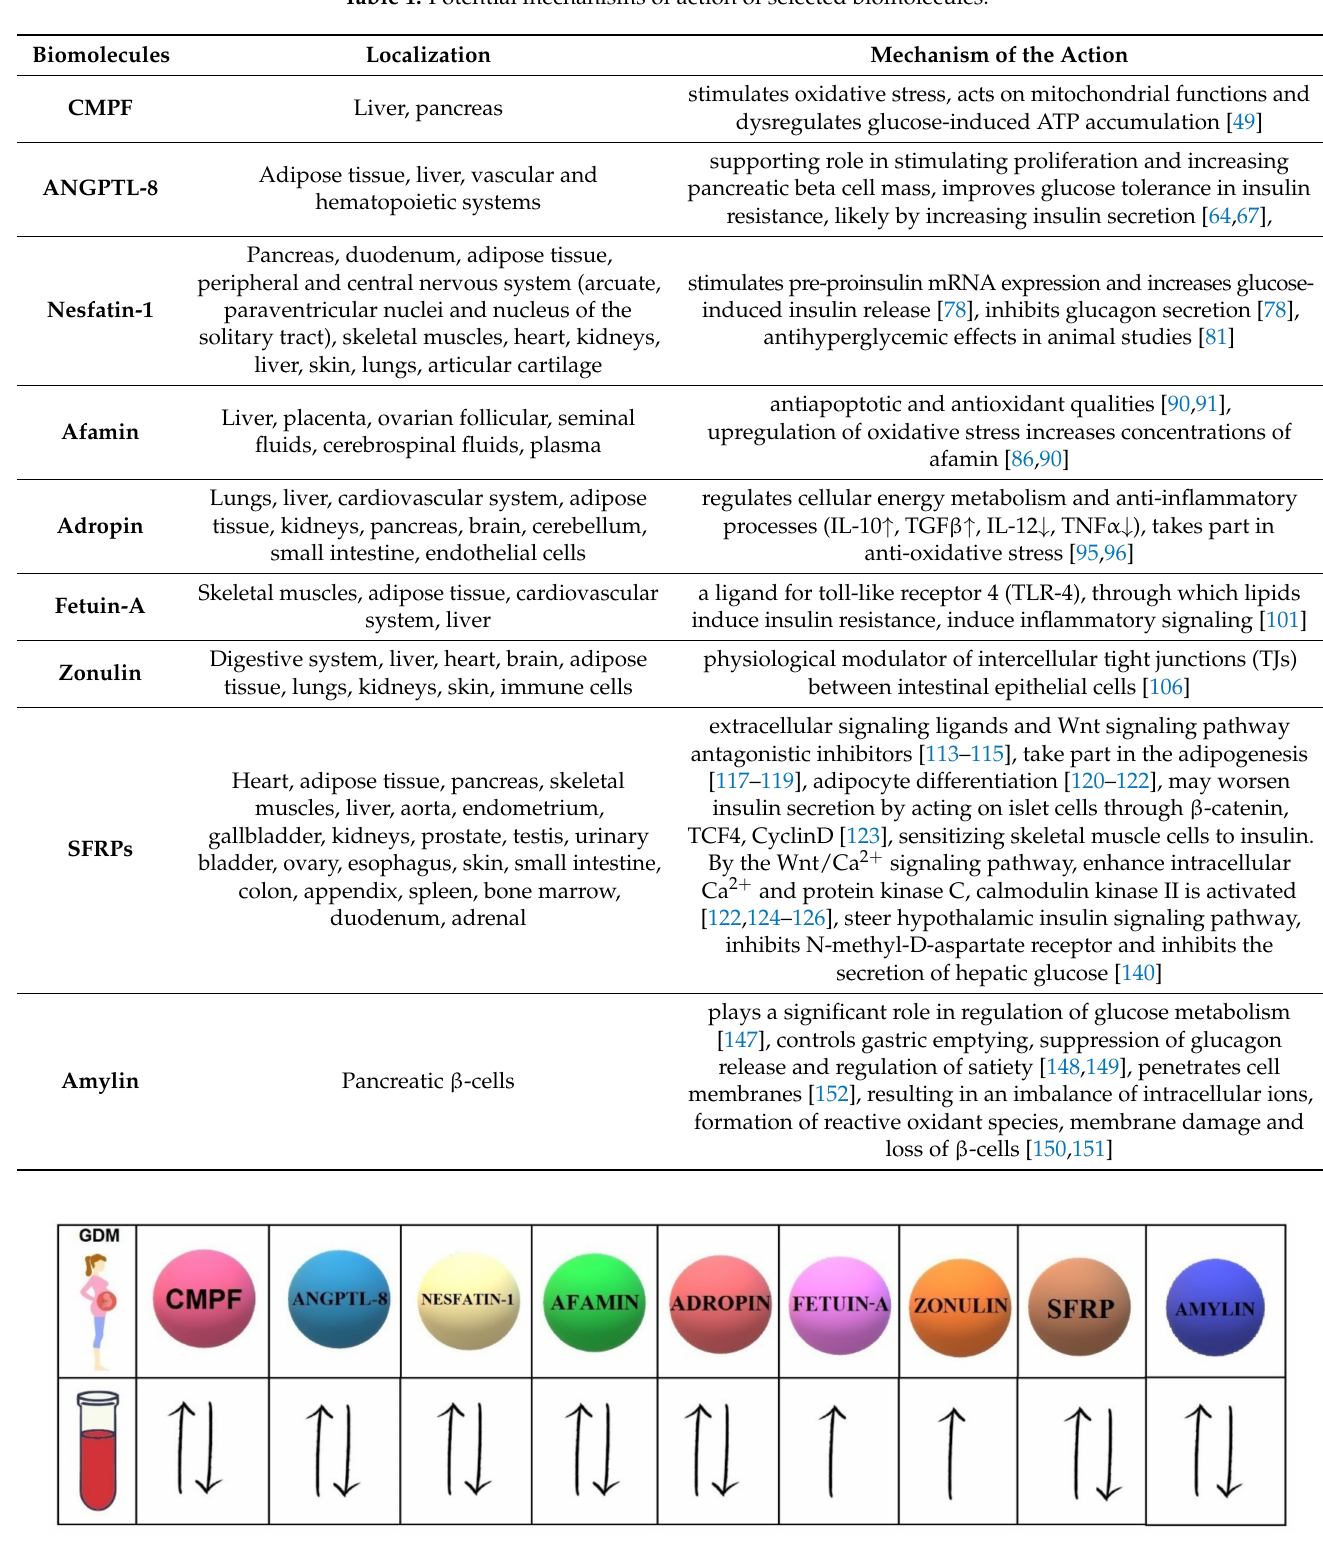
Table 1. Potential mechanisms of action of selected biomolecules.